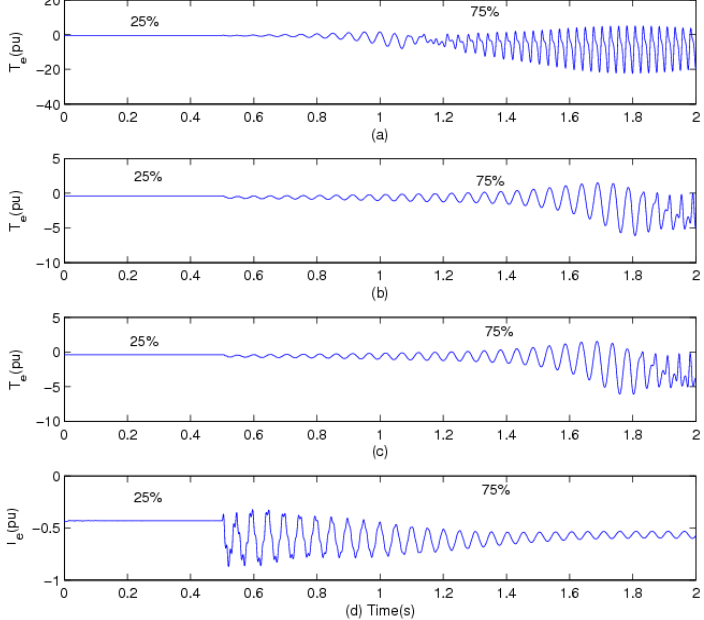
( a ) without a supplementary damping controller, e